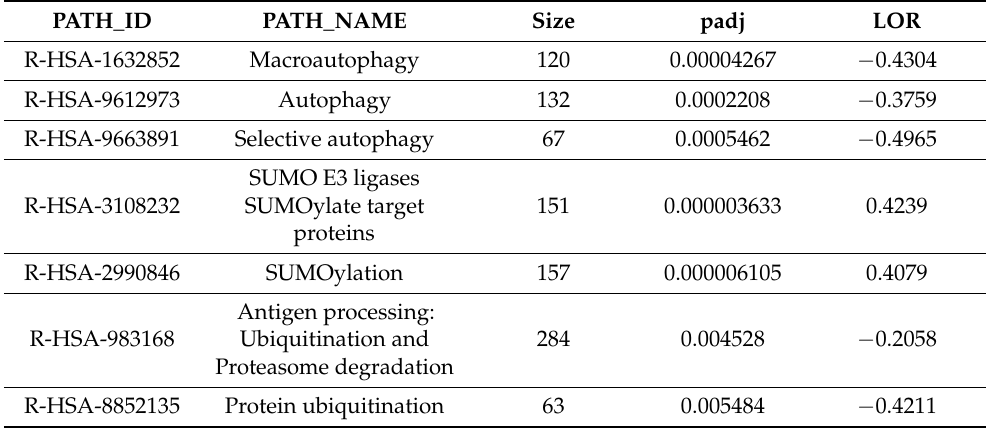
Table 3. Autophagy-related and SUMOylation-related Reactome pathways deregulated in C9ALS/DTF patients compared to the